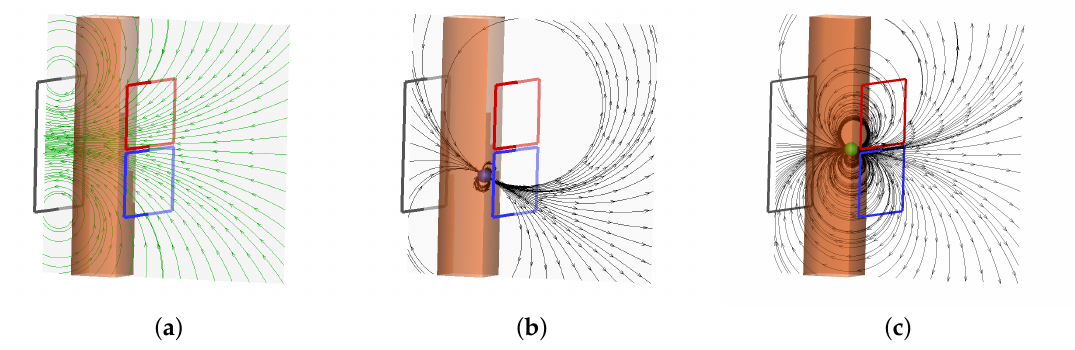
Figure 1. Principle of the measurement system with the magnetic field structure at the central plane of the excitation coil and its deformation due to the presence of a bubble. ( a ) The field lines of the magnetic field generated by the excitation coil; ( b ) Field deformation due to the presence of a bubble in lower section; ( c ) Field deformation due to the presence of a bubble at the equatorial plane. The induced voltages in both induction coils of the planar gradiometer have the same amplitude but opposite sign and therefore they cancel each other